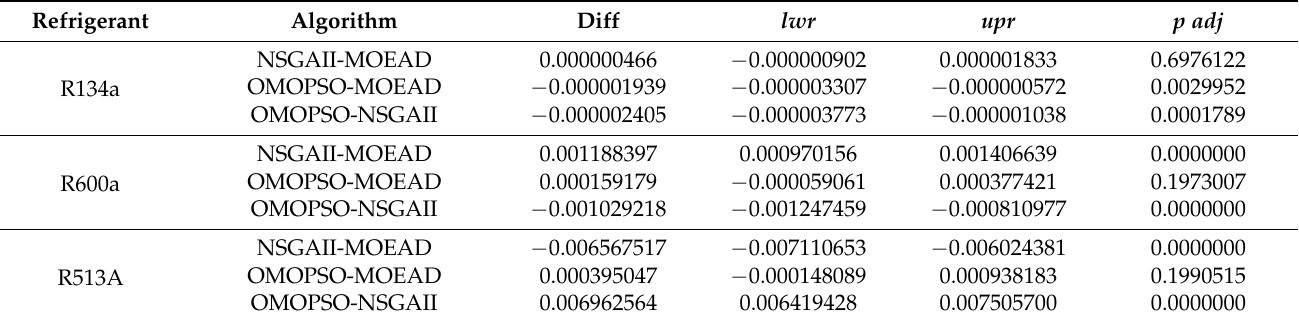
Table 3. Statistical results between algorithms for R134a, R600a, and R513A